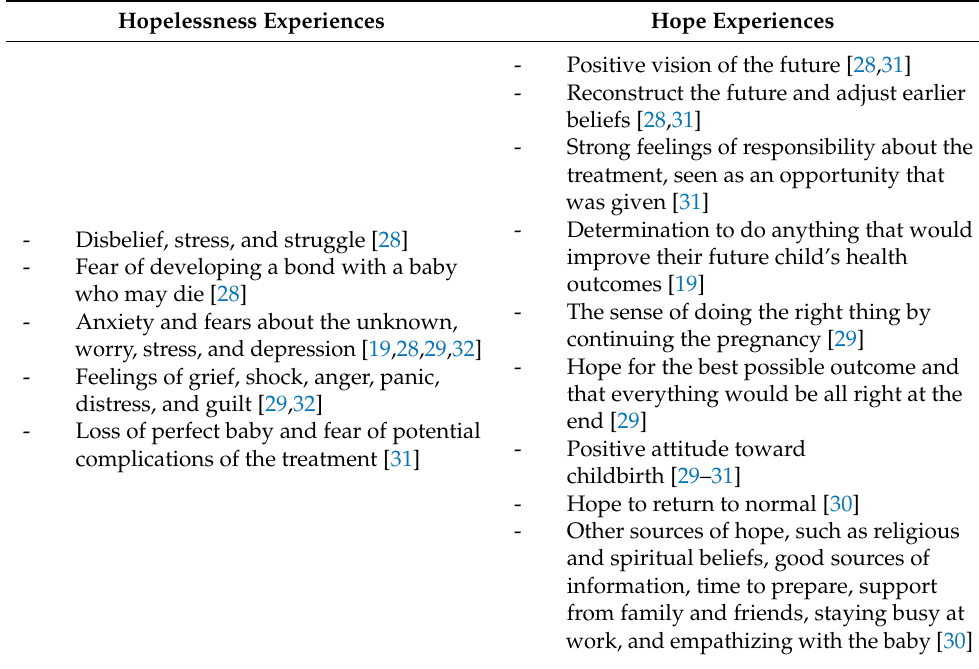
Table 2. Hopelessness and hope experiences in women with prenatal diagnoses. Hopelessness